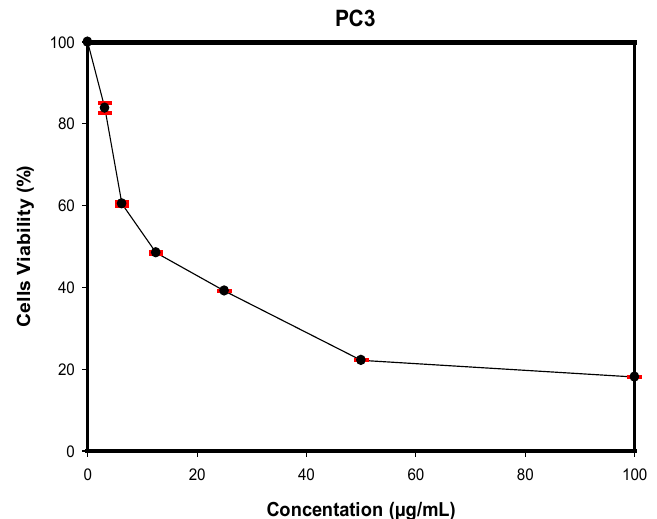
Figure 3. The effects on cell viability upon treatment with GMG-ITC at different concentrations against PC-3 cell line after 72 h of incubation. The data represented mean ± SD of three independent experiments ( n = 3).